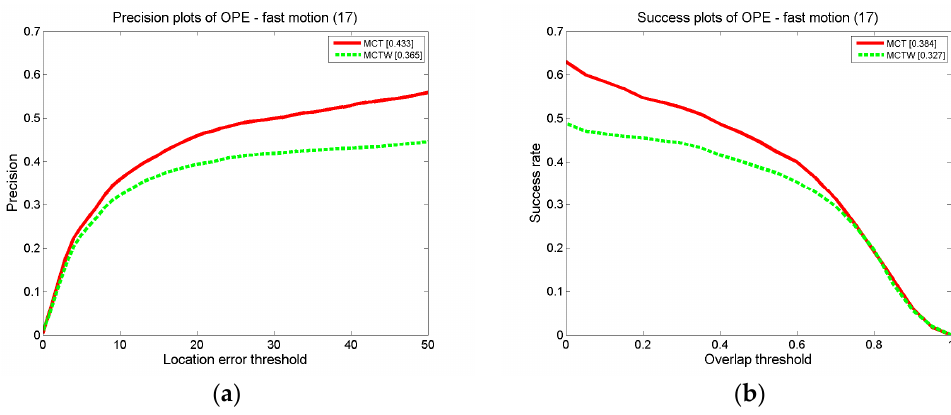
Figure 18. The precision plot ( a ) and the success rate plot ( b ) on MCT and MCTW for FM.